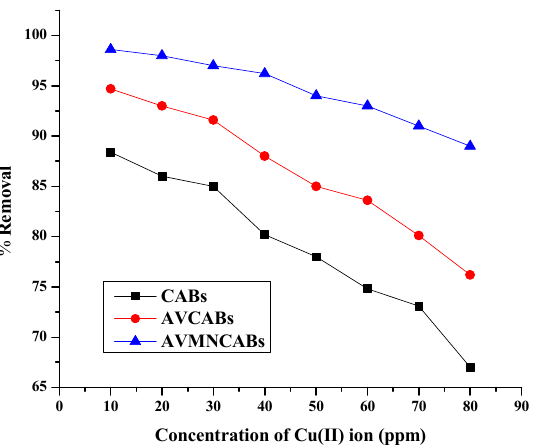
Figure 12. Effect of the initial Cu(II) concentration on the adsorption (0.2 g adsorbent, 120 min, 30 °C, pH 4).